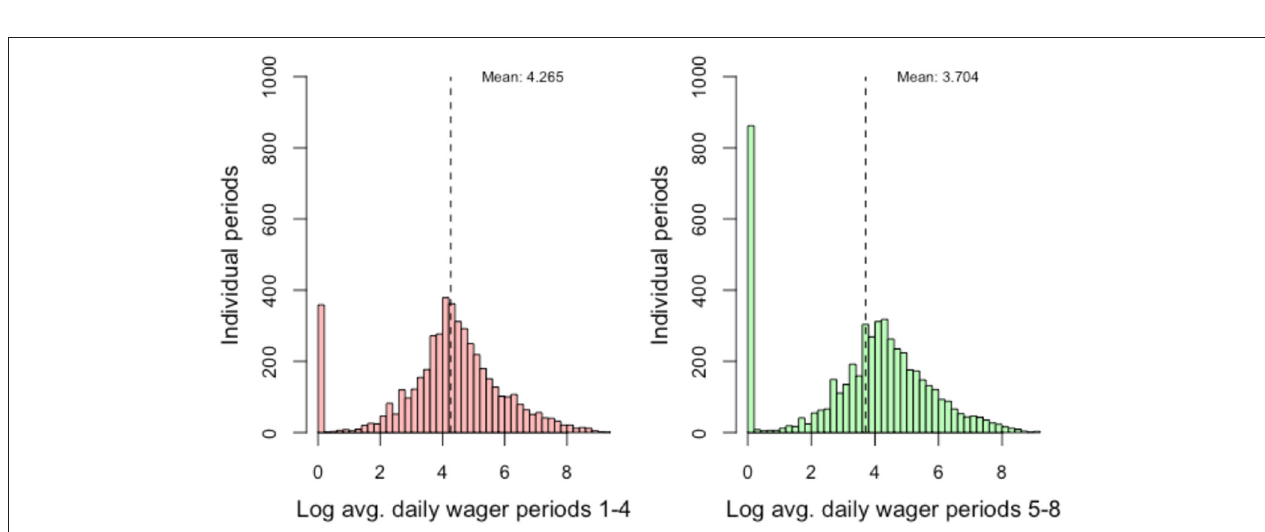
FIGURE 2 | Wager data pre- and post-intervention, logarithmized. Weeks before (weeks 1–4) and after (weeks 5–8) intervention.